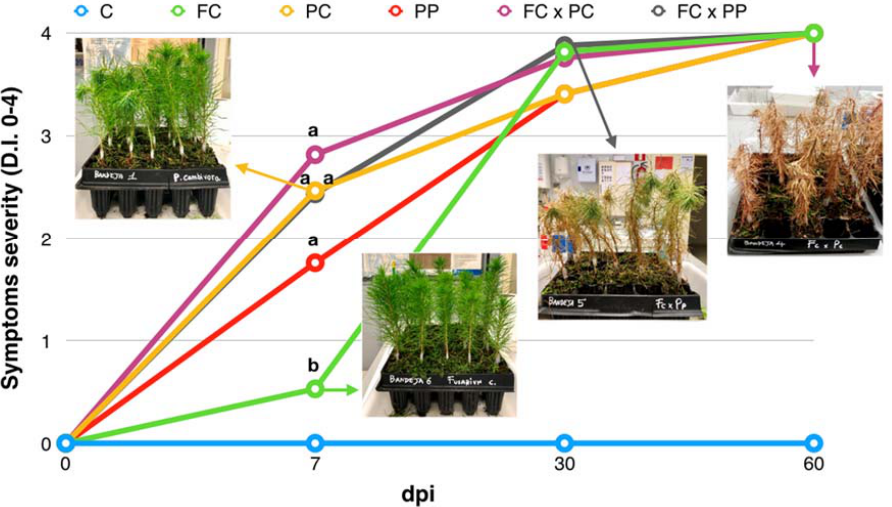
Figure 1. Time course of symptoms progression in Pinus radiata seedlings non-inoculated (C) or inoculated with Fusarium circinatum (FC), P. xcambivora (PC), P. parvispora (PP), F. circinatum * P. xcambivora (FC × PC) and F. circinatum * P. parvispora (FC × PP). Symptom severity was expressed as mean value of disease index (D.I.) at 7, 30, and 60 days post-inoculation (dpi). Images show the type of symptoms at each time interval post-inoculation. At each time interval, values sharing the same letters are not significantly different according to Tukey’s honestly significant difference (HSD) test ( p ≤ 0.05).